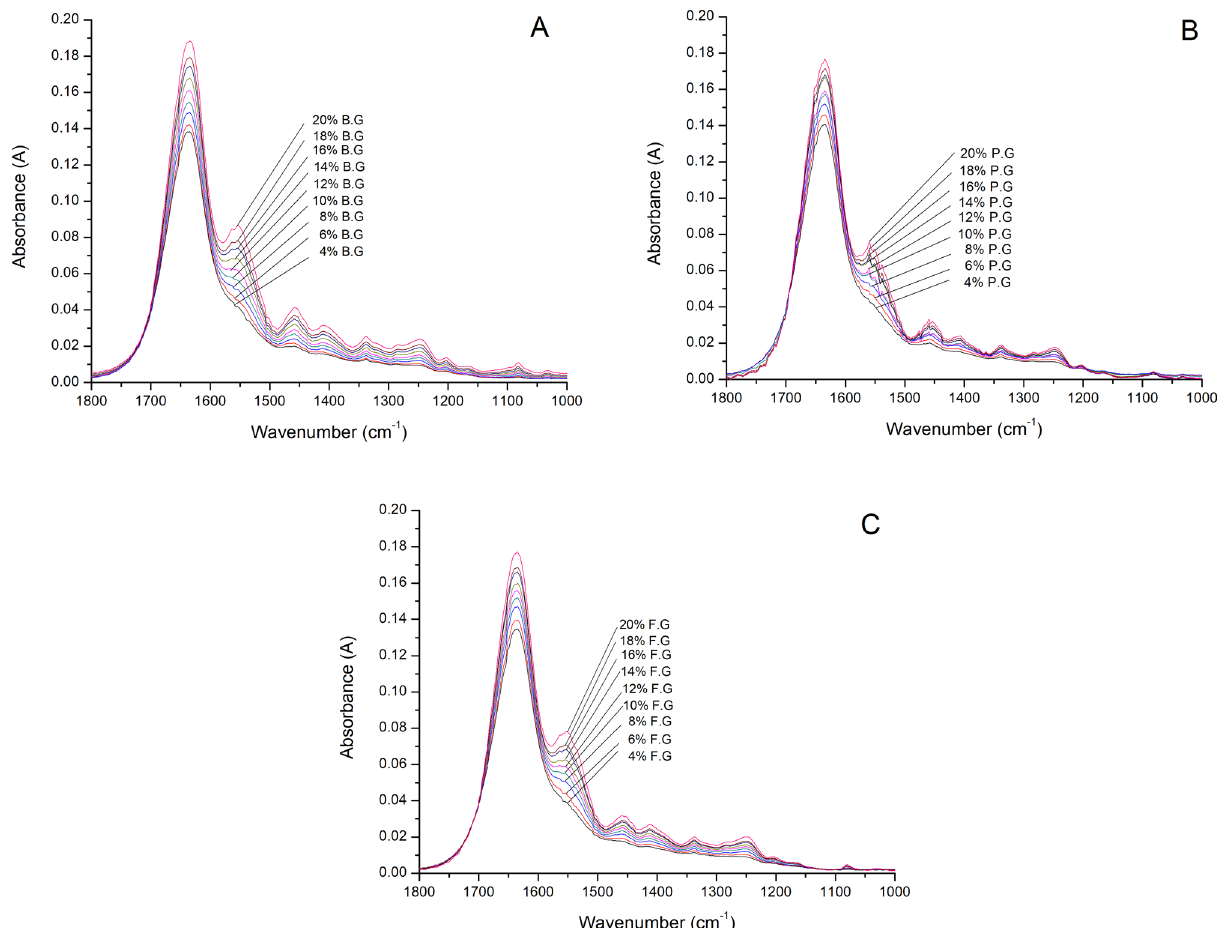
Figure 4. Concentration-dependent FTIR spectra of ( A ) bovine gelatin (B.G), ( B ) porcine gelatin (P.G) and ( C ) fish gelatin